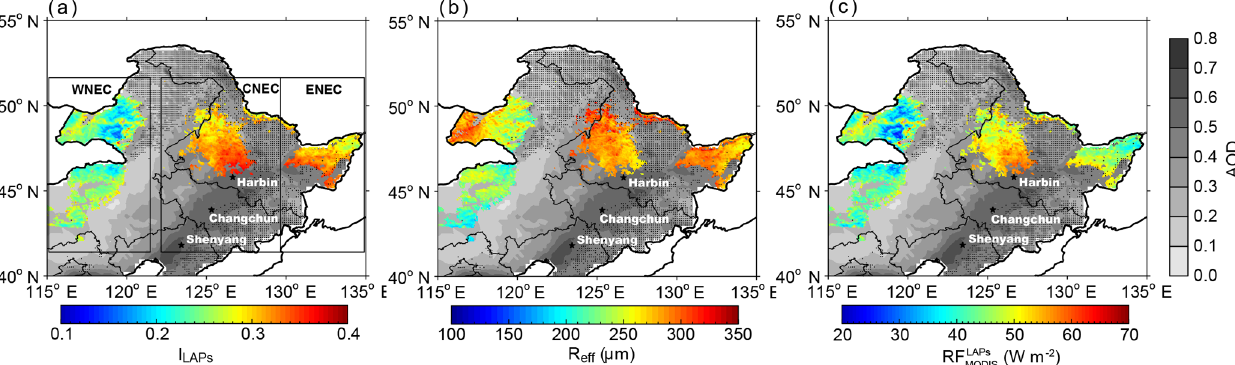
Figure 4. The spatial distributions of average (a) I LAPs , (b) R eff , and (c) RF LAPs background shows the spatial distribution of MODIS AOD values. The dotted areas are covered by forests. The major cities in NEC are also shown in this figure. According to the geographical distribution, we separate the study area into three regions: western NEC (WNEC), central NEC (CNEC), and eastern NEC (ENEC).